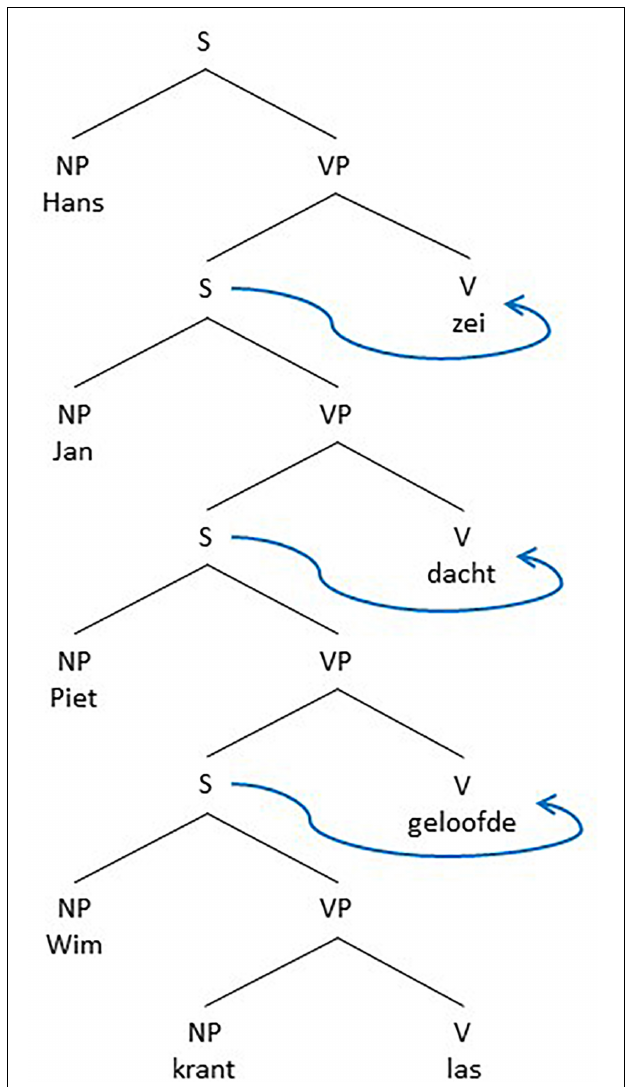
FIGURE 7 | A reduced structure of utterance (8b) and its transformation into utterance (8a).